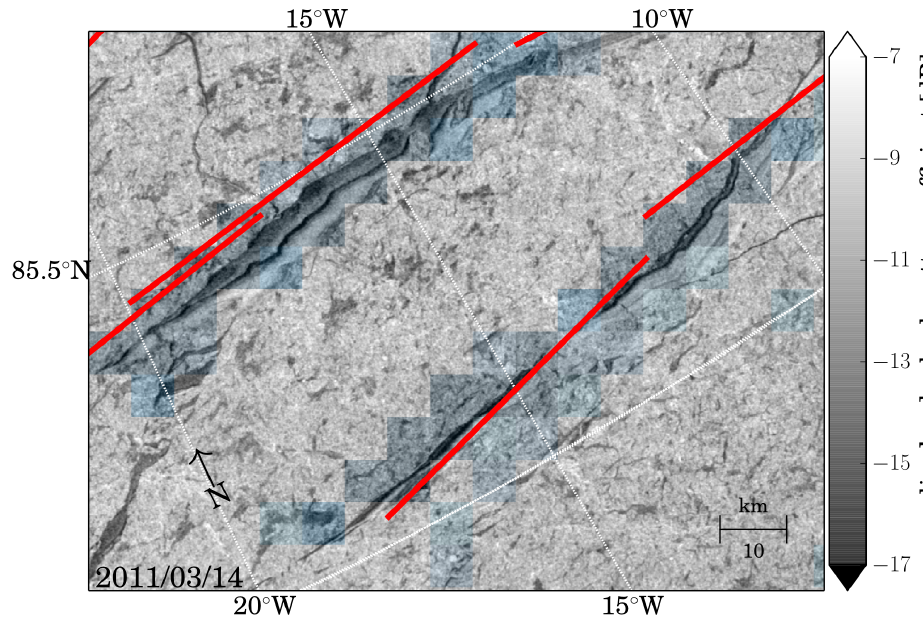
Figure 9. Validation of clustered leads detected by the Hough transform with an ASAR scene shows a high accordance for larger leads. Leads (red lines) inferred from AMSR-E lead concentration (blueish pixels) are compared to ASAR observations north of Greenland (box in Figure 2) on 14 March